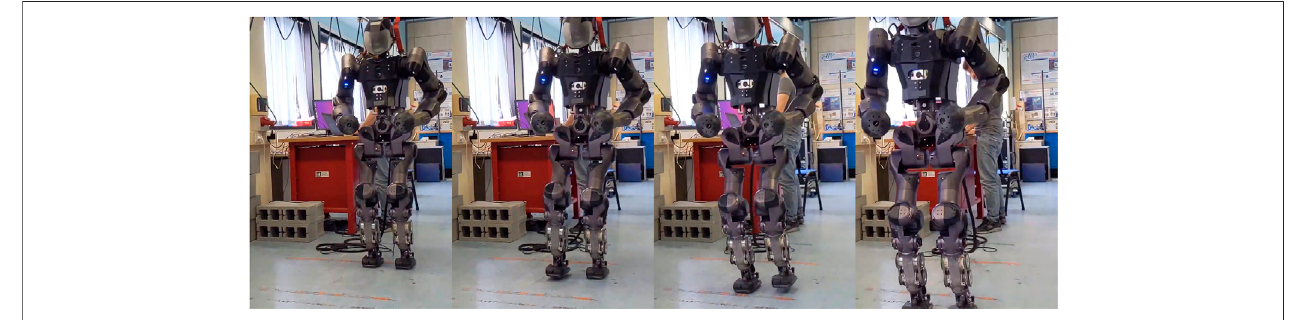
FIGURE 14 | Sequence of frames of COMAN + walking 10 step and steering of 10 + at step 3 according to the issued command.